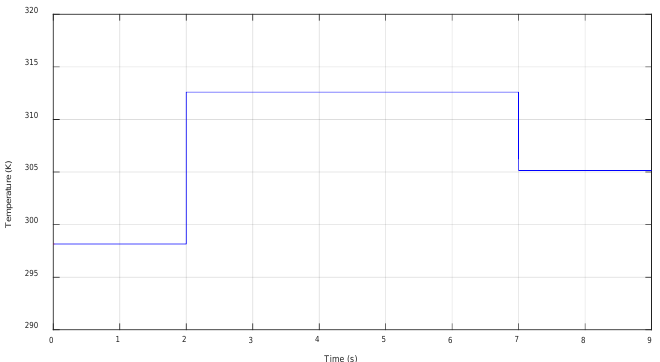
Figure 8. Temperature variation during simulation.